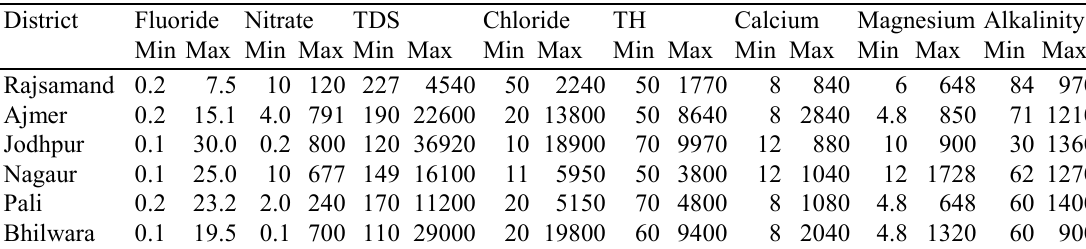
Table 4 Statistics of groundwater chemistry. District